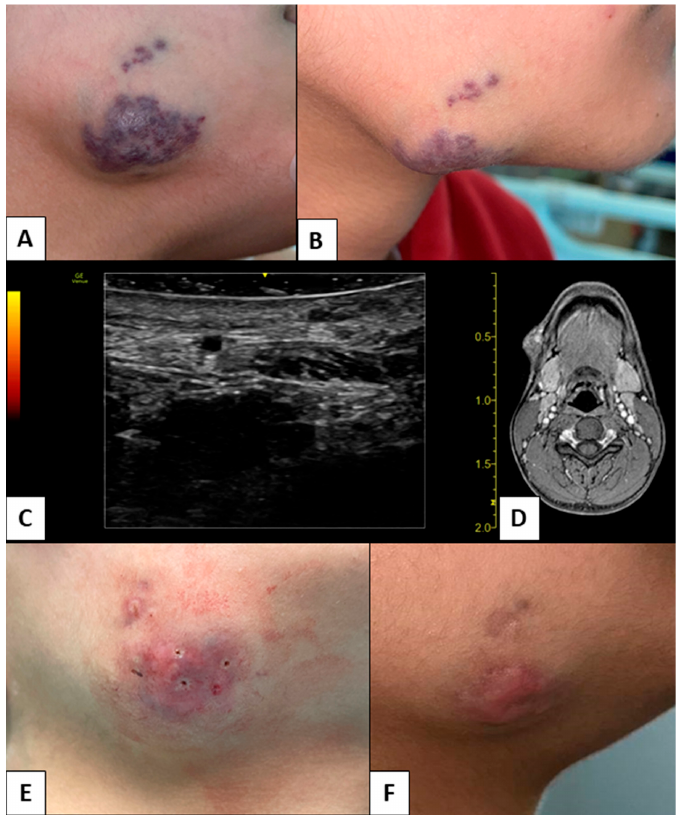
Figure 2. ( A , B ): a perioral capillary-venous malformation in a sixteen-year-old patient; ( C ): preoper- ative high-de fi nition intraoral ultrasonography; ( D ): preoperative magnetic resonance imaging; ( E ): the lesion after transmucosal thermo-photocoagulation and intralesional photocoagulation; ( F ): The follow-up after the third laser session. The treatment is still in progress.